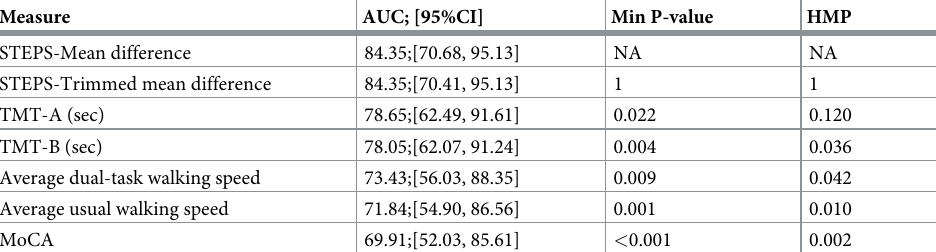
69.91;[52.03, 85.61] 0.002 Average AUC levels and average bounds of 95% bootstrap CI’s across 10-folds for distinguishing patients according to given medical status. AUC levels were tested between each measure and the STEPS-Mean difference measure within each fold, with the DeLong test. Minimal p-value, as well as the Harmonic Mean P-value (HMP) are